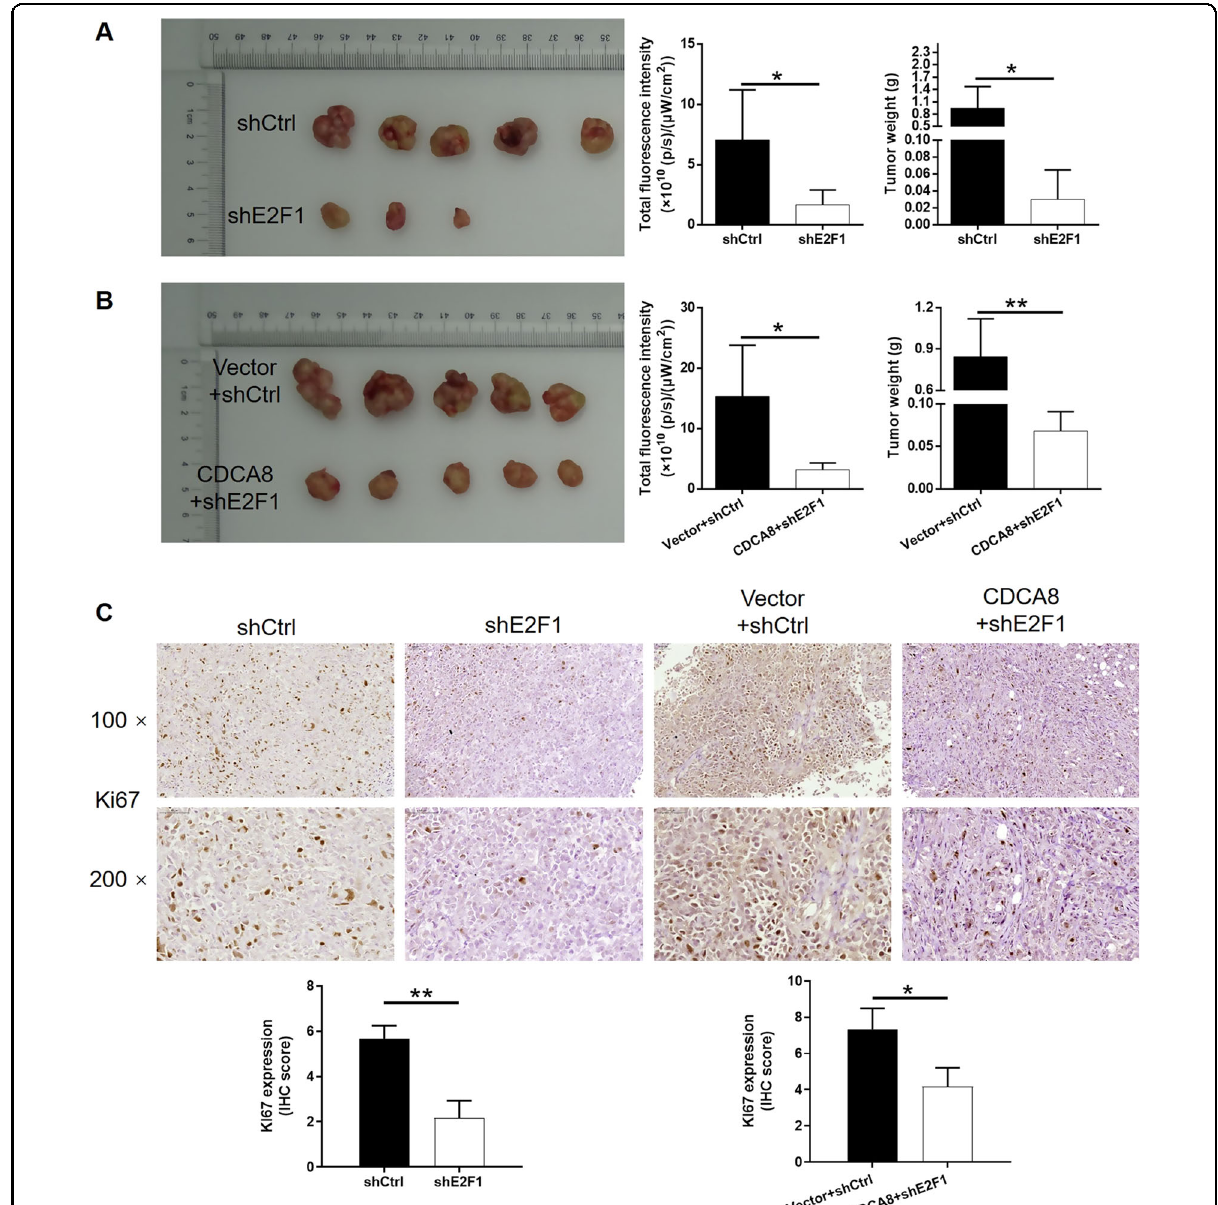
Fig. 6 CDCA8/E2F1 axis regulates glioma progression in vitro and in vivo. Mice xenograft models were constructed through subcutaneously injecting U251 cells in shCtrl, shE2F1, Vector + shCtrl, and CDCA8 + shE2F1 groups. A , B Dissected tumors from xenograft models with or without shCDCA8 after implantation were collected for taking photos. In vivo fl uorescence imaging of tumor burden was performed just before sacri fi cing the mice. Tumor weight of mice xenograft model analysis was measured after tumor collection. C Ki67 level by IHC analysis in tumor sections was detected after the tumor collection. Data were performed by mean with SD. * P < 0.05, ** P <